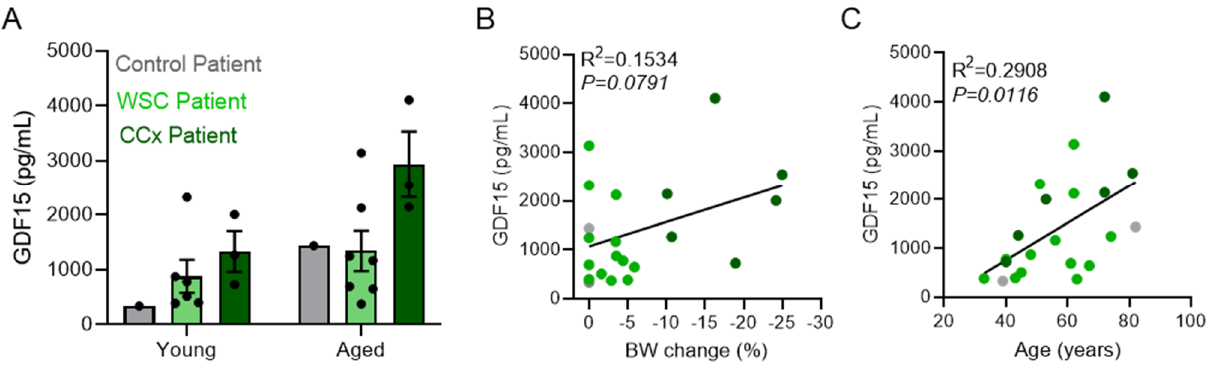
Figure 7. GDF15 significantly correlates with age of patients, but not body weight (BW) change. We compared GDF15 levels of control patients without tumor, as well as patients with gastrointestinal cancer with or without BW loss. ( A ) Total plasma GDF15 levels. ( B , C ) Linear regression analysis comparing human plasma GDF15 levels and BW change in percentage ( B ) or age in years ( C ) of patients. Data are mean ± s.e.m. Statistical analyses were performed using two-way ANOVA with Tukey’s multiple-comparison post hoc test ( A ), and simple linear regression ( B , C ). Table 2. Significant correlation between cytokine levels and weight loss only in young patients. Correlations of human plasma cytokine and metabolite levels with body weight change of control patients without cancer, and patients with gastrointestinal cancers with and without body weight loss. Numbers of tested patients are included in the table. R 2 and significance were calculated using simple linear regression analysis and significant changes are highlighted in orange.